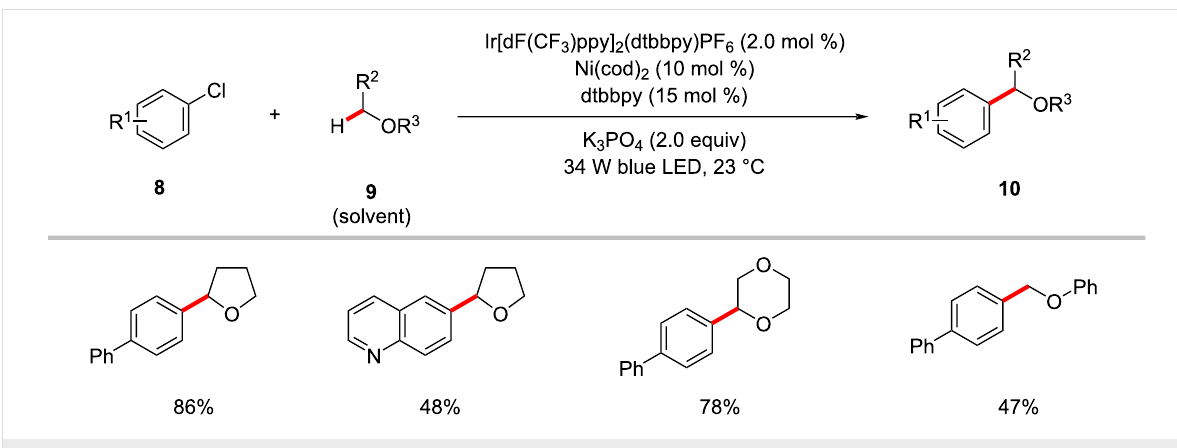
Concurrently, Molander and co-workers also reported a